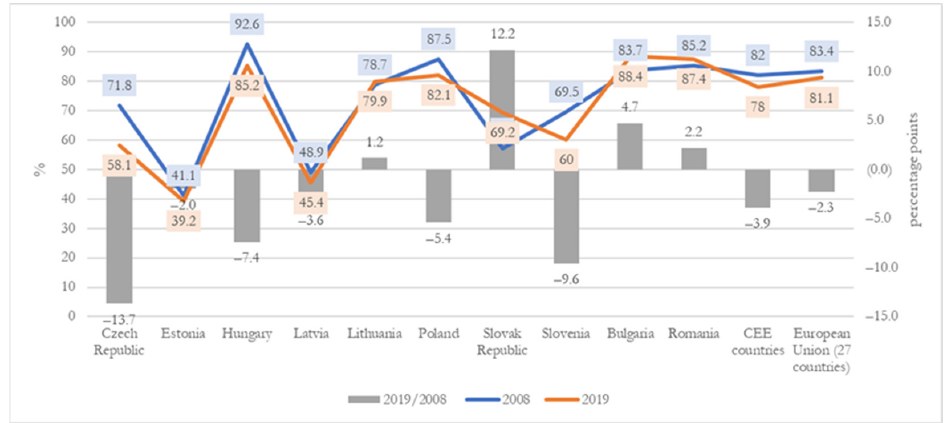
Figure 1. Domestic extraction used-share of biomass for food and feed in total biomass (%) (based on OECD.Stat data [36], retrieved on 15 February 2022).